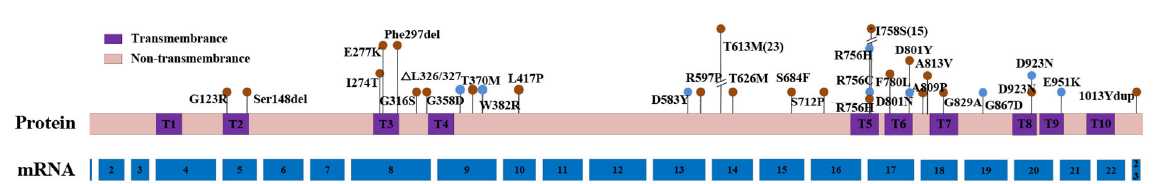
FIGURE2 Schematic diagram of the location of RDP or intermediate AHC/RDP-causing mutations in ATP1A3 mRNA and protein. Red dots show RDP-causing mutations and blue dots dedicate intermediate AHC/RDP- causing mutations. The height of the dot represents the number of reported cases for this mutation, the shortest dot represents only one reported case for this mutation. The number of mRNA represent each corresponding exon. RDP, rapid-onset dystonia parkinsonism; AHC, alternating hemiplegia of childhood.